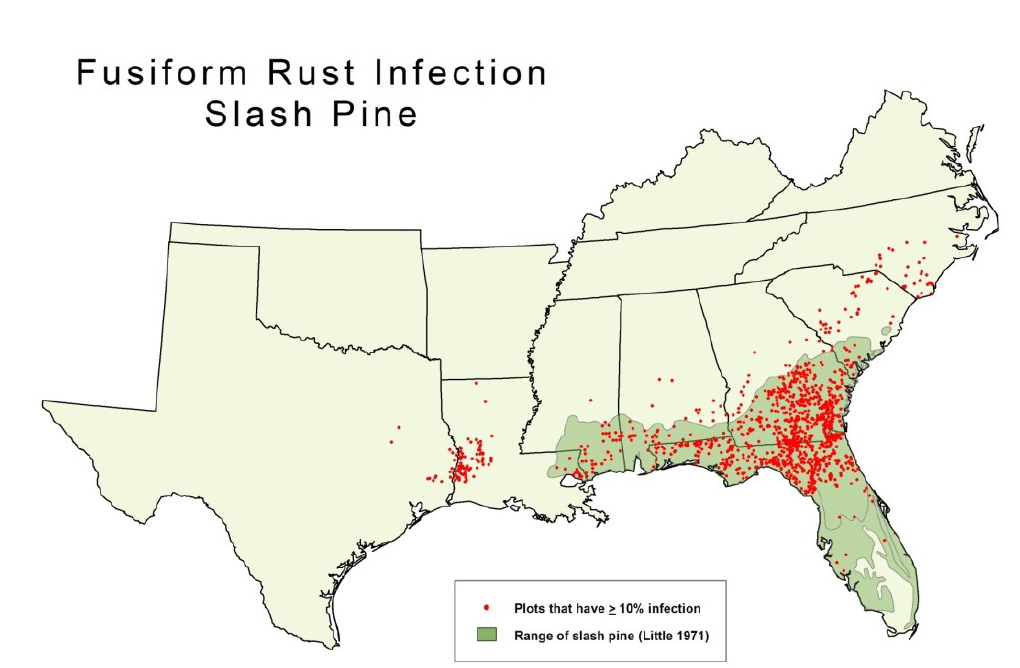
Figure 4. Locations of Forest Inventory and Analysis plots with the slash pine forest type and >10% fusiform rust infection on trees at least 1.0 inch in diameter at breast height. Estimates of infection are based on FIA inventories between 1987 and 1994. Reproduced from Starkey et al.